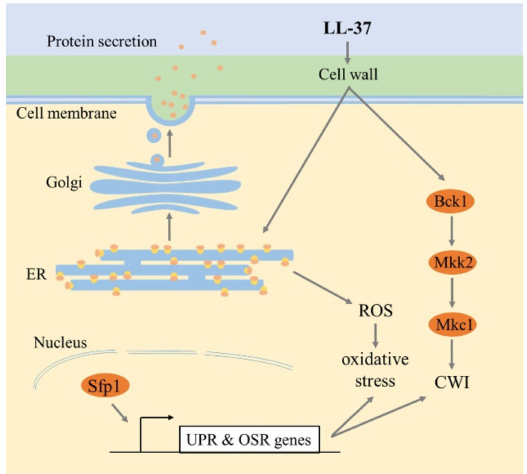
Figure 8. An overview of the role of Sfp1 in the cellular stress response induced by LL-37. Based on the findings of previous studies and this study, LL-37 targets cell wall components and causes cell wall remodeling. Consequently, LL-37 activates the Mkc1 MAP kinase signaling pathway to maintain cell wall integrity (CWI). LL-37 also triggers the UPR pathway to adapt and respond to ER stress conditions. Moreover, LL-37 likely induces ER-derived ROS accumulation to cause oxidative stress and affects ER-related protein secretion. Interestingly, analyses of deletion of the SFP1 gene further correlated the role of the transcription factor Sfp1 in cell wall maintenance, ER homeostasis and oxidative stress response upon LL-37 treatment. OSR genes: oxidative stress responsive